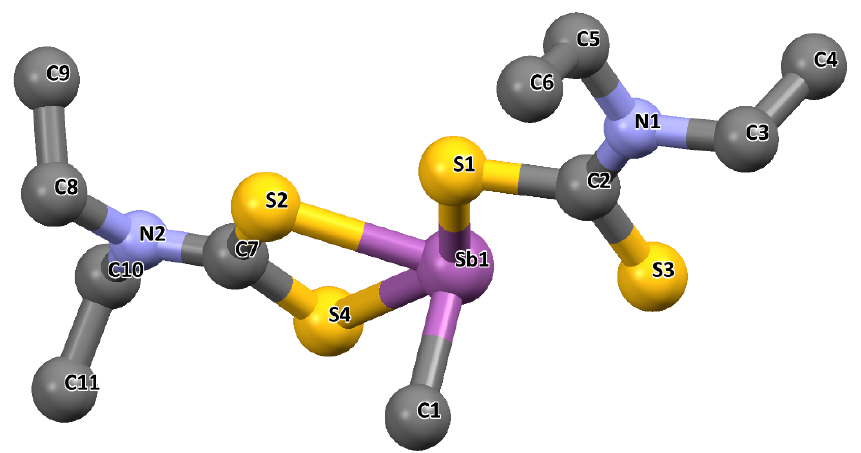
Figure 8. Crystal structure of the complex and the labelling scheme [CH 3 Sb(SaCNEt 2 ) 2 ]. All hydrogen atoms are omitted for clarity. Redrawn from [63], with permission from John Wiley and Sons (copyright 2019).